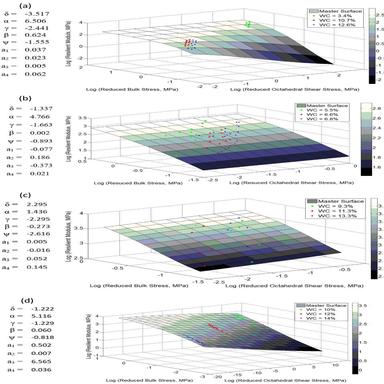
Examples of MR Master Surface Development after Horizontally Shifting Data a-1) YSSG Subgrade, b-1) GLAB2 Granular Base, c-1) MSF2 Stabilized Material, and d-1) RPCC Recycled Material.